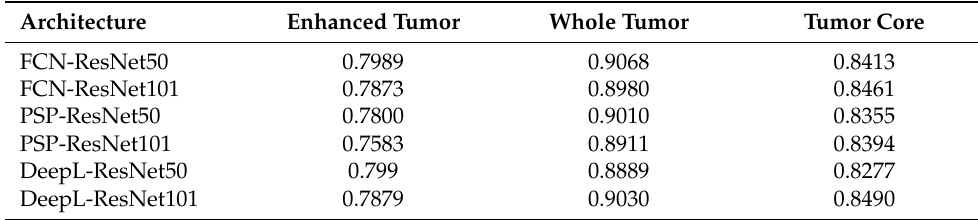
Table 10. Dice for Different Tumor Regions.